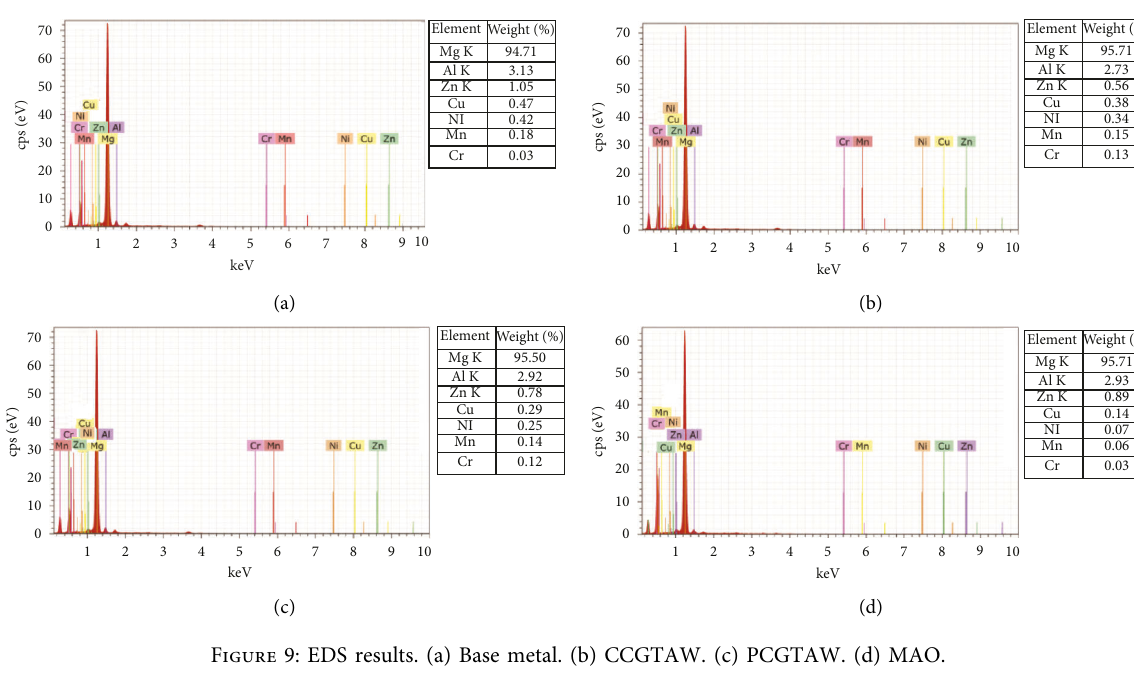
Figure 9: EDS results. (a) Base metal. (b) CCGTAW. (c) PCGTAW. (d) MAO.